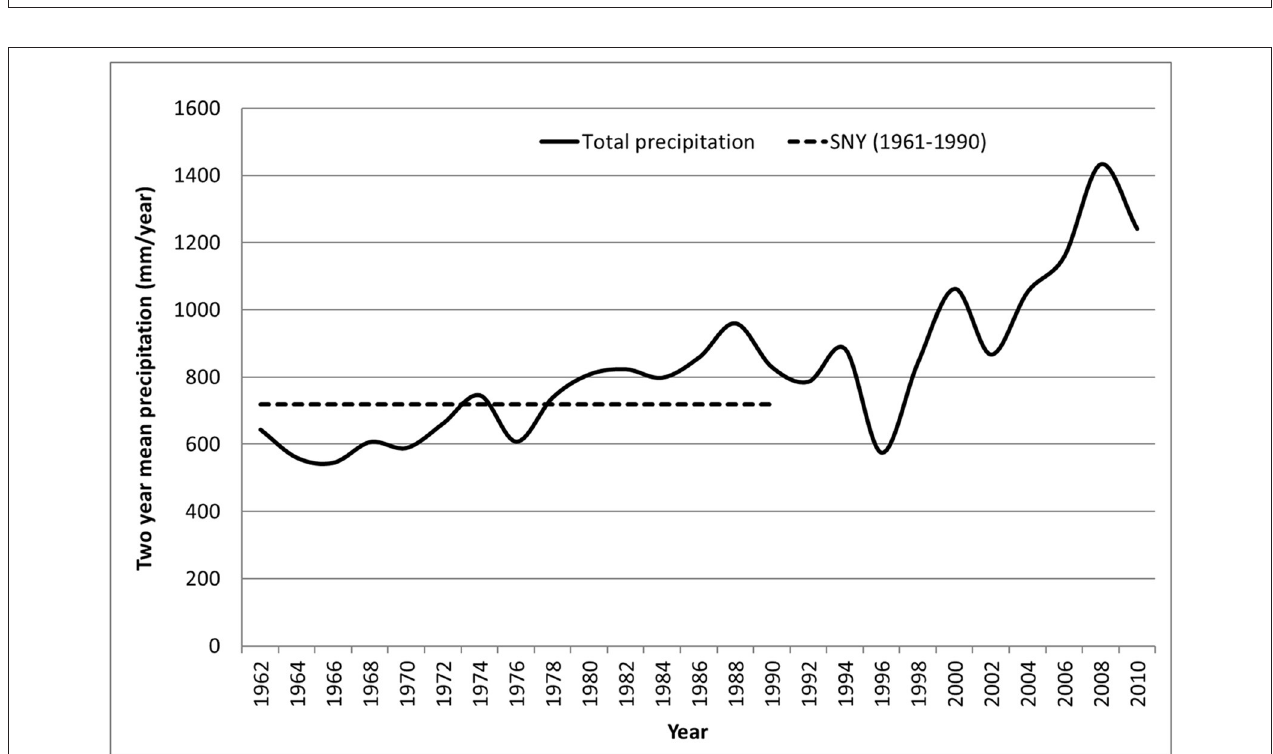
FIGURE 7 | Diagram showing the correlation between metals and suspended sediment concentrations (SSC), discharge (Q), accumulated precipitation (P), and groundwater level (GWL). Correlation to discharge has been normalized to be comparable (the direction of the correlation is otherwise negative).